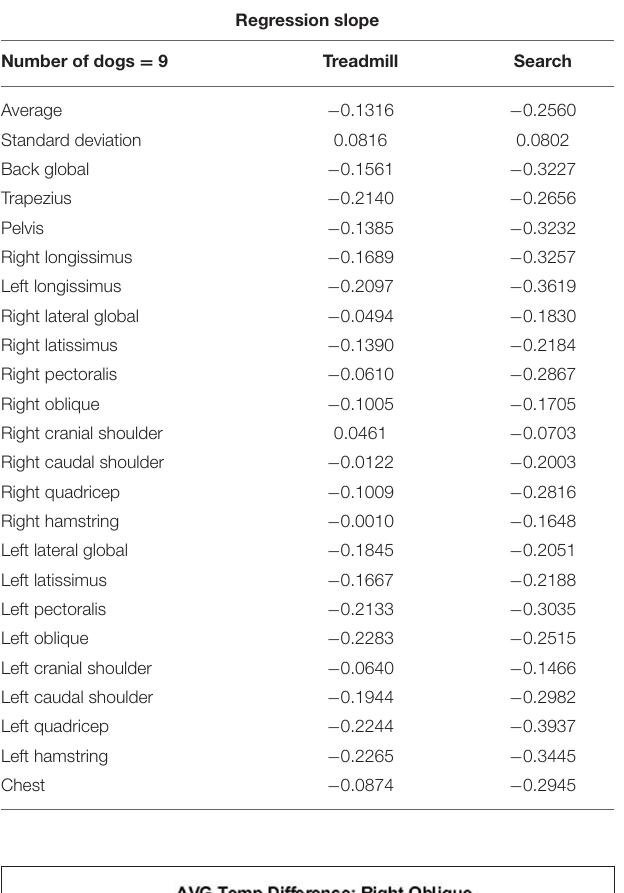
TABLE 1 | Regression slope data for treadmill and search data across all muscle groups. Regression slope